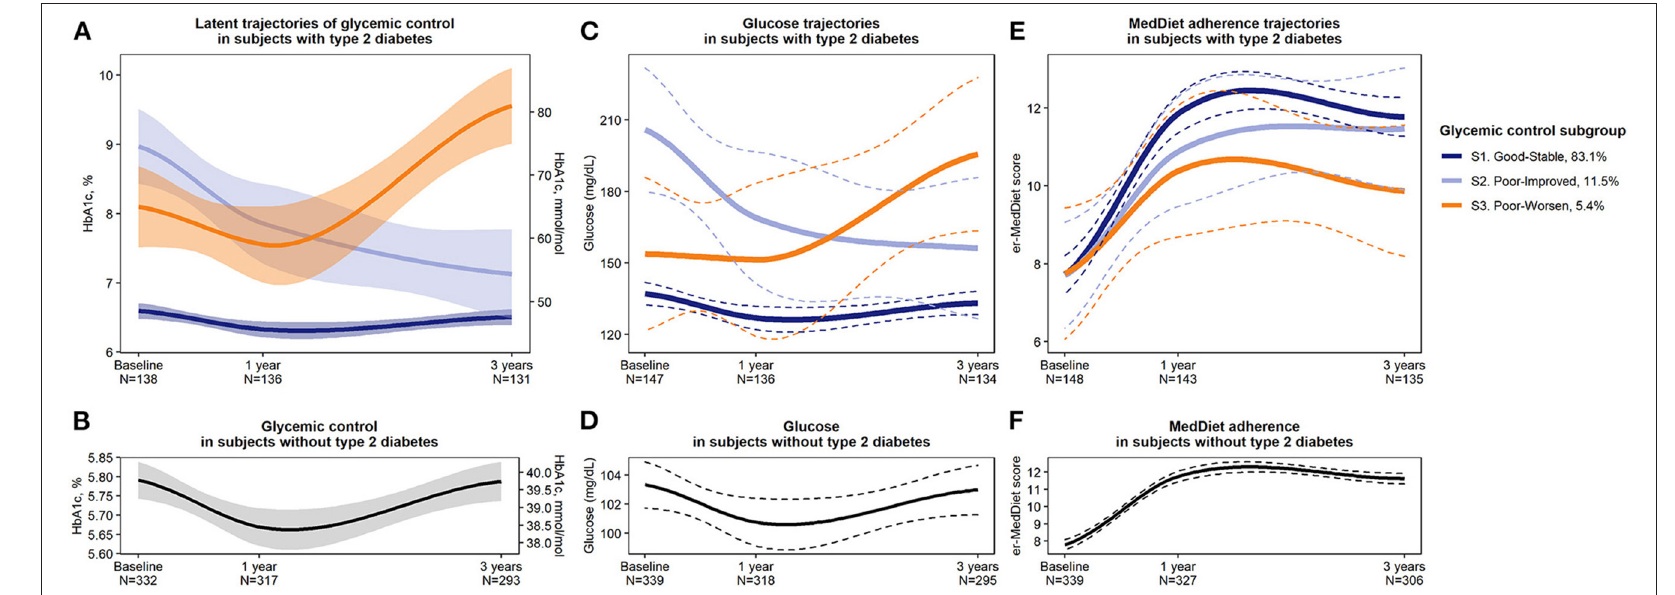
FIGURE 2 | Representation of (A) glycemic control (HbA1c) latent trajectories or subgroups in subjects with diabetes, (B) HbA1c trajectory in subjects without diabetes, (C) fasting plasma glucose levels in each subgroup of subjects with diabetes and (D) in individuals without diabetes, and (E) er-MedDiet adherence score in diabetes subgroups and (F) in subjects without diabetes. Solid lines represent mean values, and shaded areas or dashed lines represent 95% confidence intervals (95% CI). HbA1c, glycosylated hemoglobin. N , number. S,